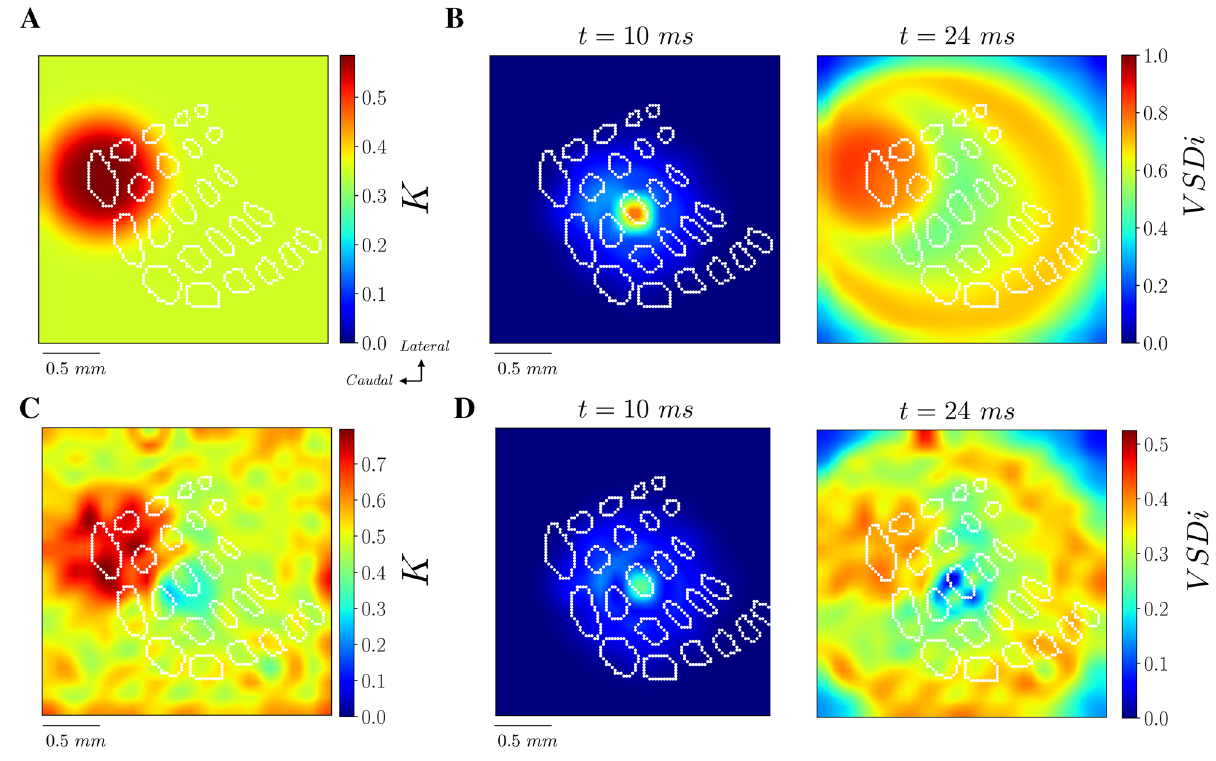
Figure 3. Spatial couplings inferred from synthetic VSD imaging data. (A) Spatial distribution of couplings K. ( B) Propagating wave emerging in response to a C2 whisker stimulus (at t = 0 ms) in the computational model with couplings as in ( A) . ( C) Reconstructed distribution of coupling K with the inversion procedure applied to the VSD activity from ( B) . ( D) Propagating wave with the reconstructed distribution of coupling K as in ( C) .